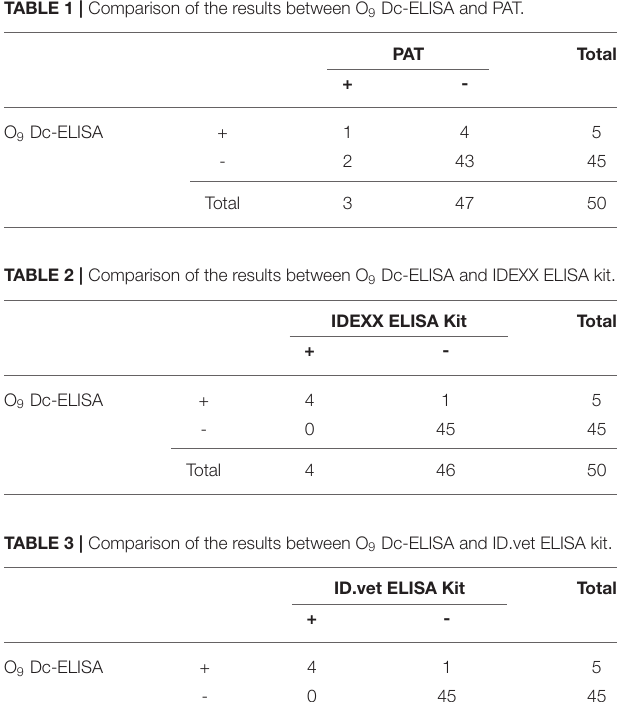
TABLE 1 | Comparison of the results between O 9 Dc-ELISA and PAT.